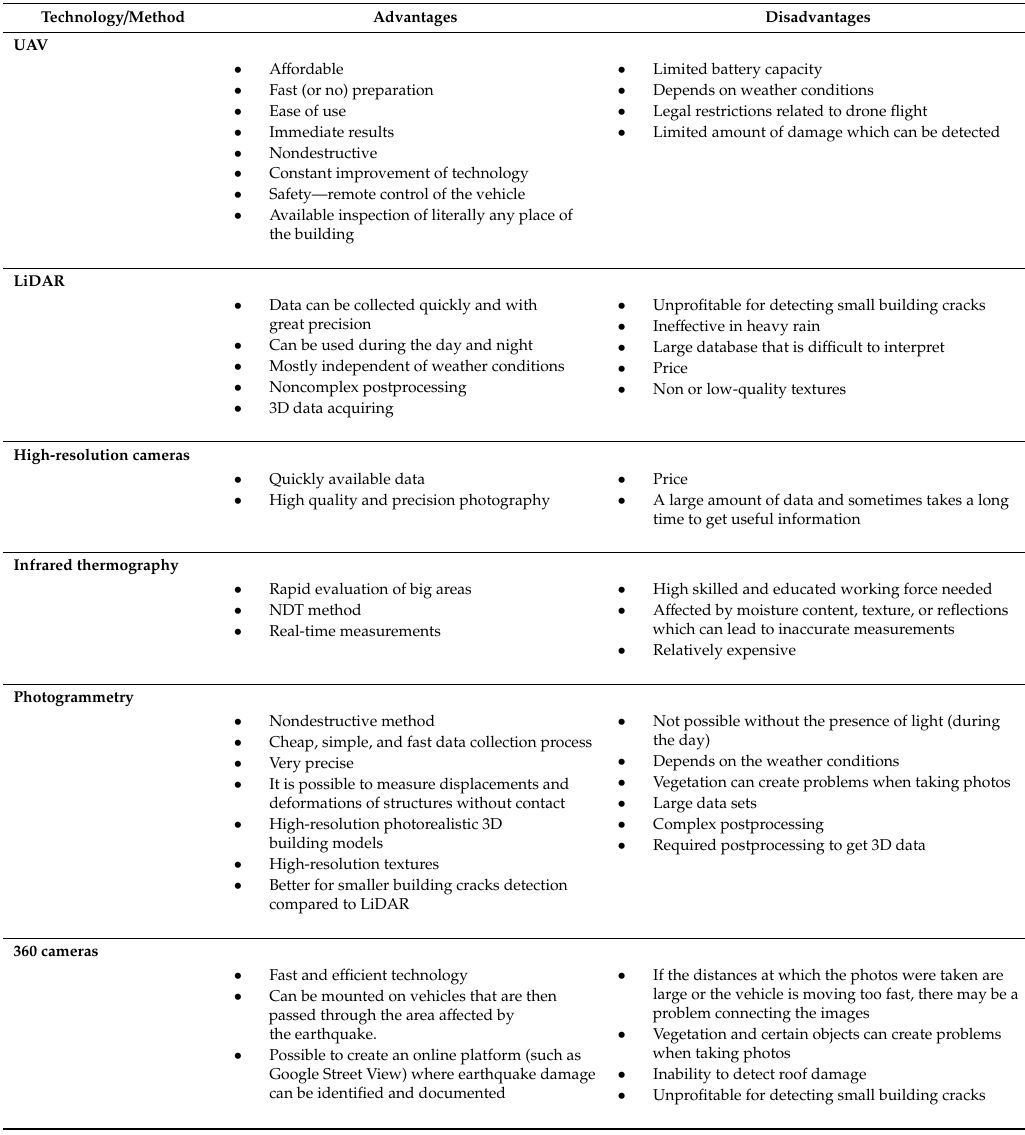
Table 2. Basic advantages and disadvantages of new technologies for the rapid assessment of the vulnerability of